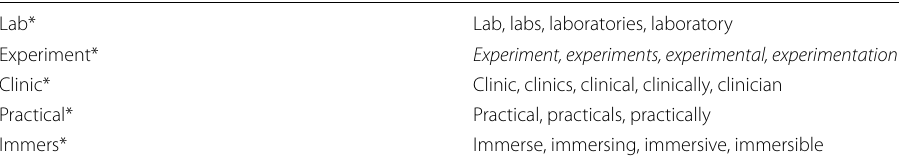
Table 1 The used keywords with wildcards to cover all keyword forms